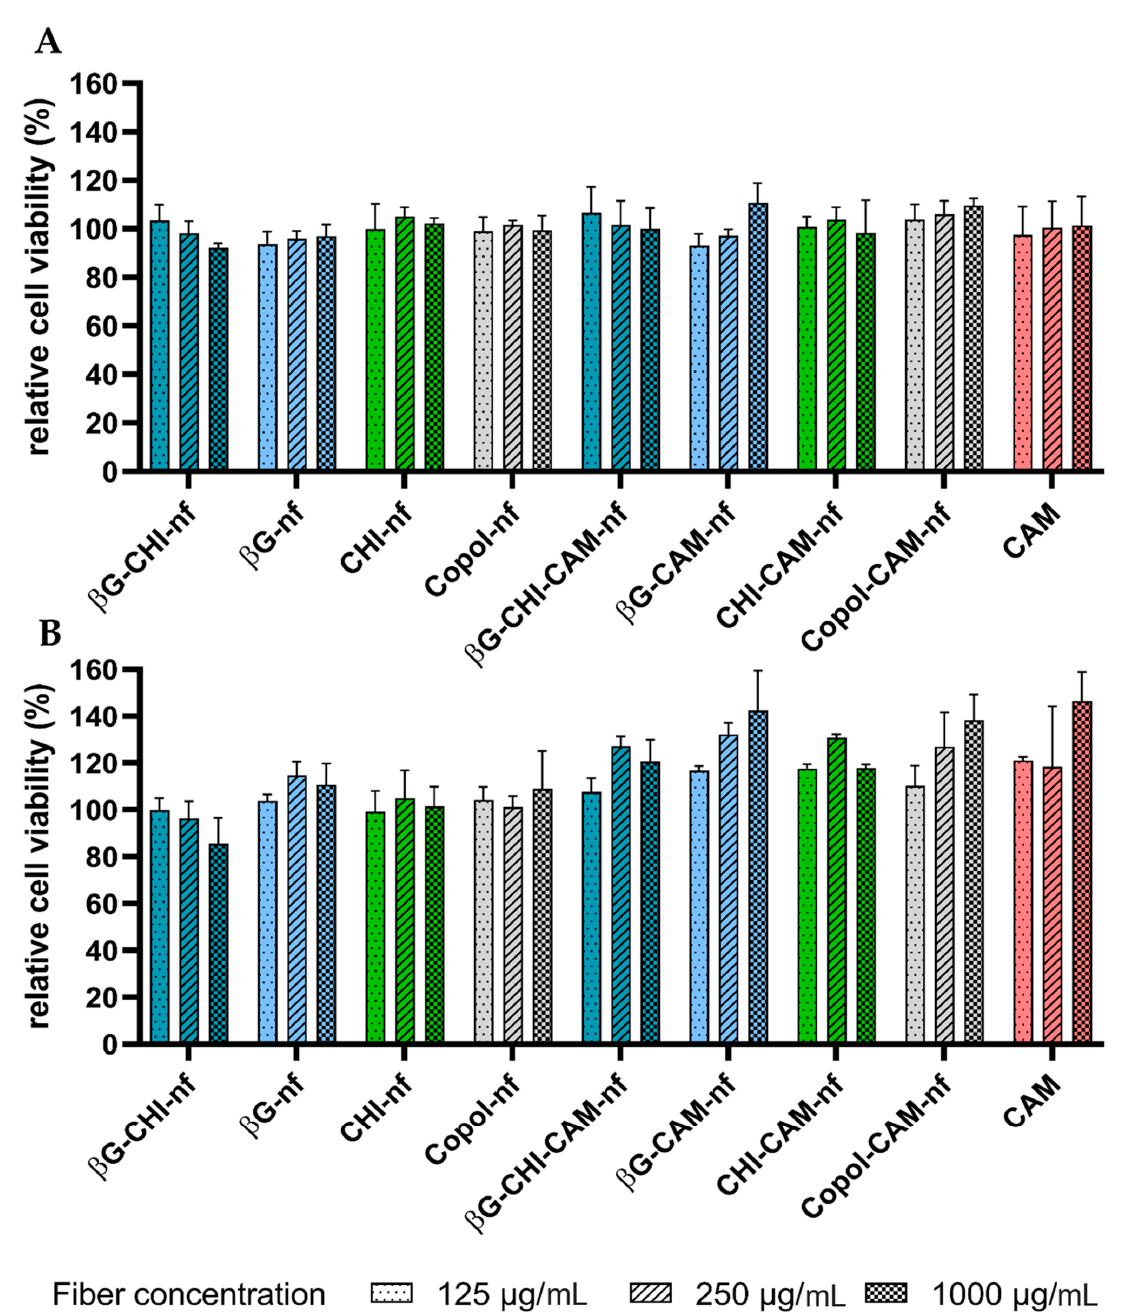
Figure 3. Relative cell viability (%) of ( A ) HaCaT cells and ( B ) macrophages (RAW 264.7) after 24 h incubation at 37 °C and exposure to nanofibers (dissolved in concentrations of 125, 250 and 1000 µg/mL) and chloramphenicol (CAM) (in concentrations of 1.25, 2.5 and 10 µg/mL). Results are presented as mean ± SD ( n = 3). Abbreviations: β G ( β -glucan), CHI (chitosan), Copol (co-polymers: polyethylene oxide and hydroxypropylmethylcellulose), CAM (chloramphenicol), nf (nanofiber).